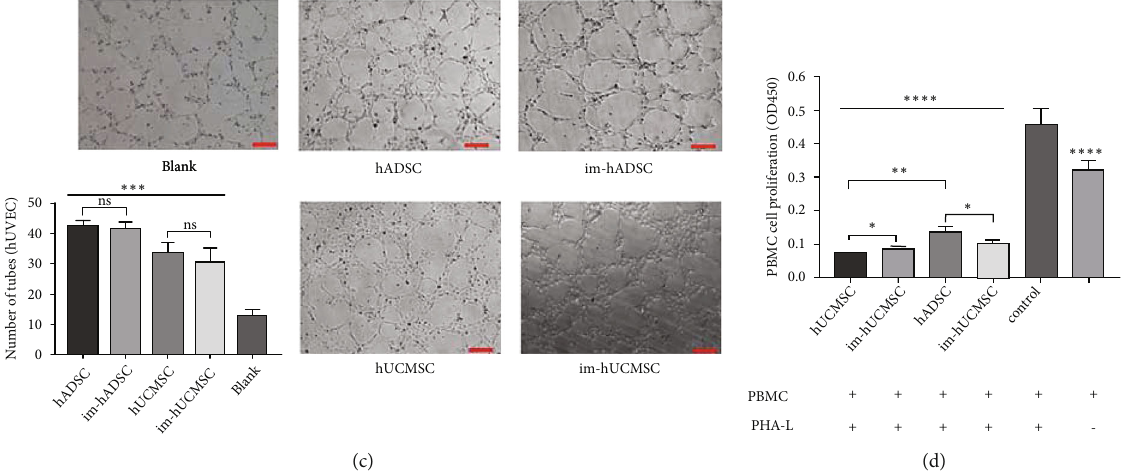
Figure 1: Immunophenotype, directed di ff erentiation and functional properties of MSC and im-MSC. (a) Flow cytometry showing surface markers of mesenchymal stem cells from hADSC and hUCMSC. Immortalization of mesenchymal stem cells did not change the immunophenotype of mesenchymal stem cells. (b) As de fi ned by ISCT, hADSC, hUCMSC, and immortalized mesenchymal stem cells, all have the ability to di ff erentiate into osteoblasts (magni fi cation, × 100), chondroblasts (magni fi cation, × 200), and adipocytes (magni fi cation, × 400). Scale bar, 400 μ m. (c) Representative capillary tubule structures were shown for HUVECs treated with culture medium collected from the indicated MSC and im-MSC. magni fi cation, × 200, scale bar, 100 μ m. (d) Proliferation of PBMC co-cultured with MSC from di ff erent sources treated with mitomycin C. hADSC: human adipose-derived mesenchymal stem cells; hUCMSC: human umbilical cord mesenchymal stem cells; ISCT: International Society for Cell & Gene Therapy. ∗ P < 0 : 05 , ∗∗ P < 0 : 01 , ∗∗∗ P < 0 : 001 , ∗∗∗ ∗ P < 0 : 0001 . ns: not signi fi